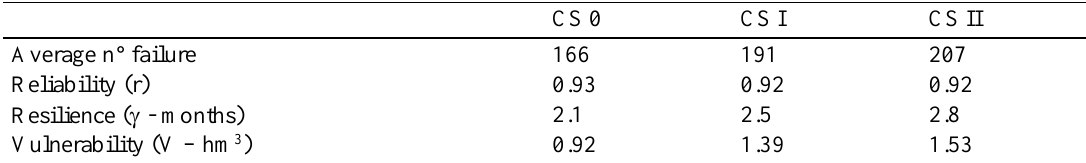
Fig. 5 Ten-years moving average for failure duration (left panel) and failure volume (right panel) for different climate scenarios. Table 2 Performance indices for different climate